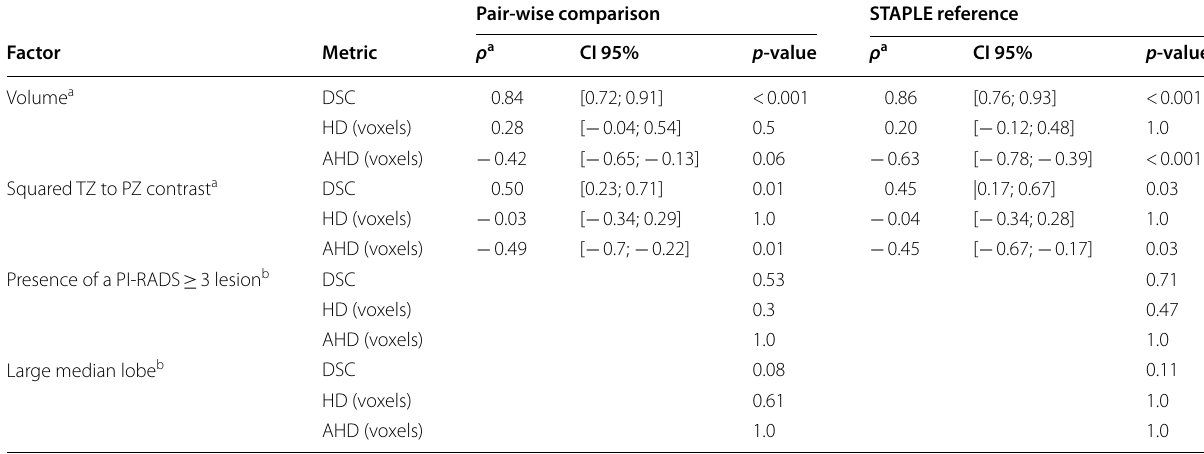
Table 3 Impact of various factors on segmentation variability with 2 methods (pair‑wise comparison and consensus comparison (STAPLE